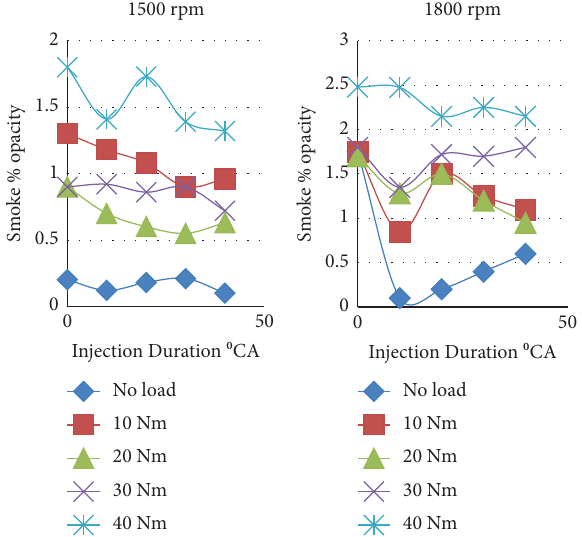
Figure 9: Exhaust smoke for diferent H at 1800rpm and